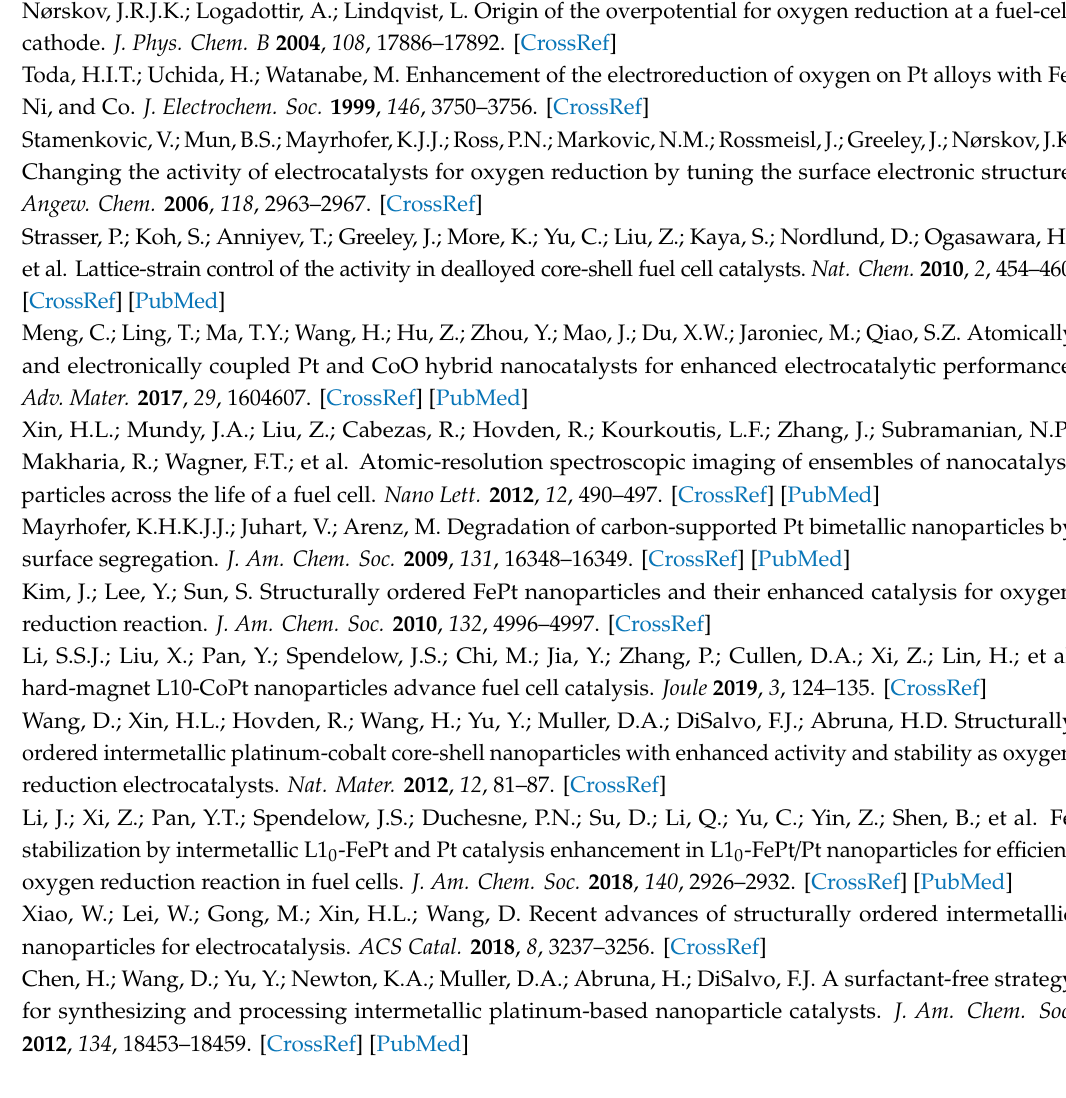
Figure S1: ORR LSV curves before and after electrochemical dealloying by 200 potential cycles between 0.06 and 1.0 V / RHE at 500 mV / s, Figure S2: The CV curves of dealloyed ternary alloys annealed at 400 ◦ C, Figure S3: The TEM images and EDS result. (a)The morphology and EDS results of as-prepared Pt 40 Co 60 ; (b) the TEM image of Pt 40 Co 60 -H600, Figure S4: The electrochemical testing results of Pt 40 Co 60 annealed at 400 and 600 ◦ C. (a) the CV curves of Pt 40 Co 60 -H400 and Pt 40 Co 60 -H600; (b) the LSV curves of Pt 40 Co 60 -H400 and Pt 40 Co 60 -H600, Table S1: The EDS and ICP compositions of ternary alloys and their mass percentages of Pt, Table S2: Lattice parameters (Å) derived from XRD for di ff erent Pt ternary catalysts. The lattice parameter for pure Pt is 3.926 Å, Table S3: The electrochemical surface areas (ECSAs) of ternary alloys (cm2 / mgPt), Table S4: Comparison of the half-wave potentials (E 1 / 2 ), mass activities and kinetic currents, Table S5: The EDS compositions of PtCoFe-H400 and PtCoFe-H600 at three di ff erent stages. Author Contributions: Conceptualization, Z.W. and L.G.; Methodology, Z.W. and X.Y.; Software, Y.K. and D.X.; Formal Analysis, Z.W., X.Y., D.X., and Y.K.; Writing-Original Draft Preparation, Z.W.; Writing-Review &